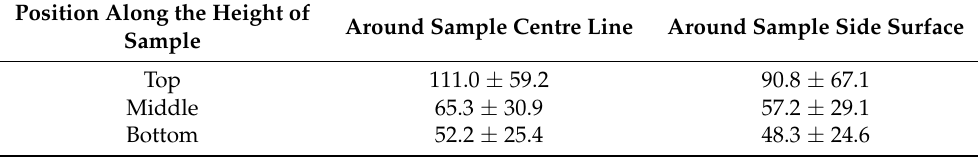
Table 3. β Grain size (µm) at different segments on the sample.